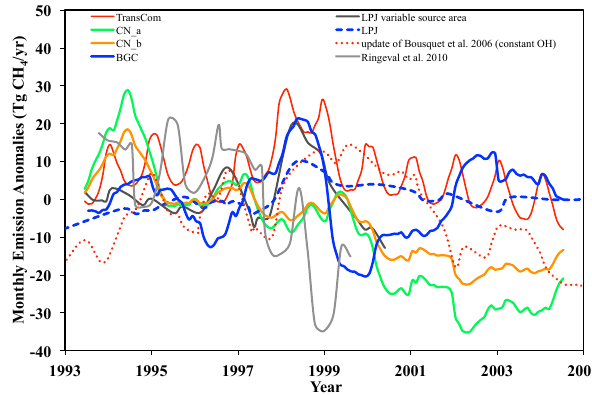
Figure 16. Comparison of the interannual variability in wetland CH 4 emissions used in this study and in others. A centered 12- month running mean filter has been applied to smooth monthly output. Data for “LPJ variable source area”, “LPJ”, and “update of Bousquet et al. (2006) (constant OH)” are obtained from Spahni et al. (2011). “LPJ variable source area” indicates emissions anoma- lies for 1993–2000 calculated by using the observed monthly inun- dated area (Prigent et al., 2007). “LPJ” indicates global CH 4 emis- sion anomalies simulated by LPJ (natural ecosystem and rice agri- culture) for scenario SC2 listed on Spahni et al. (2011). “update of Bousquet et al., 2006 (constant OH)” refers to global wetland emission anomalies derived from long-term atmospheric synthesis inversion updated from Bousquet et al. (2006). TransCom refers to emission anomalies derived from the combined wetland and rice paddy emissions. Methane emissions in Ringeval et al. (2010) are estimated using the ORCHIDEE global vegetation model with a process-based wetland CH 4 emission model. The wetland area is prescribed to the observed monthly inundated area (Prigent et al., 2007) in Ringeval et al. (2010). The mean anomalies over 1993– 2000 are adjusted to zero for the all data plotted on this graph.